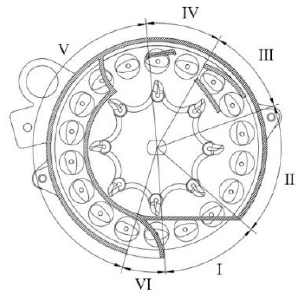
Figure 2. Diagram of the working area: I. Seed-filling area; II. Seed-suctioning area; III. Seed-adjusting area; IV. Seed-cleaning area; V. Seed-carrying area; and VI. Seed-unloading